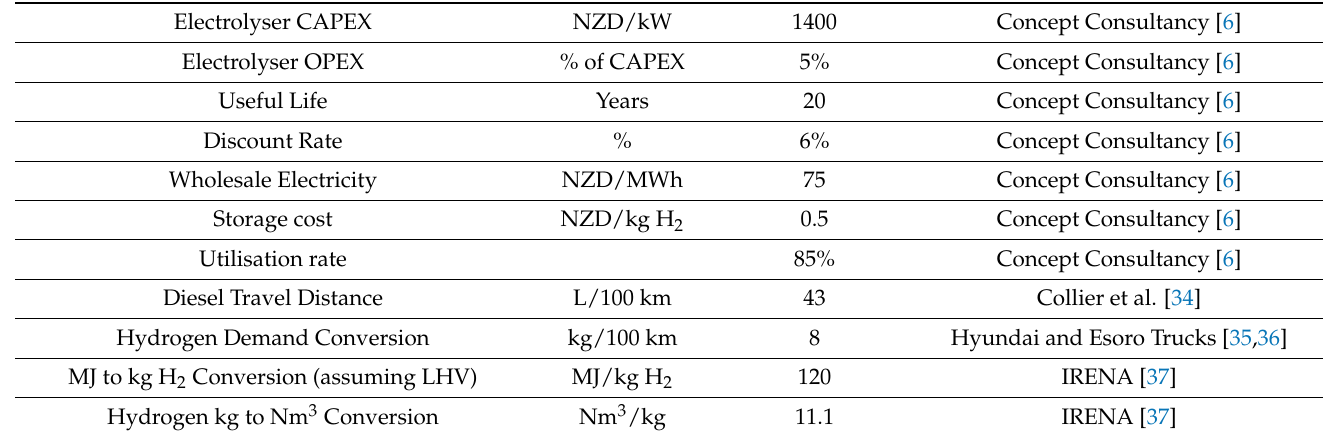
Table 1. Techno-economic assumptions.